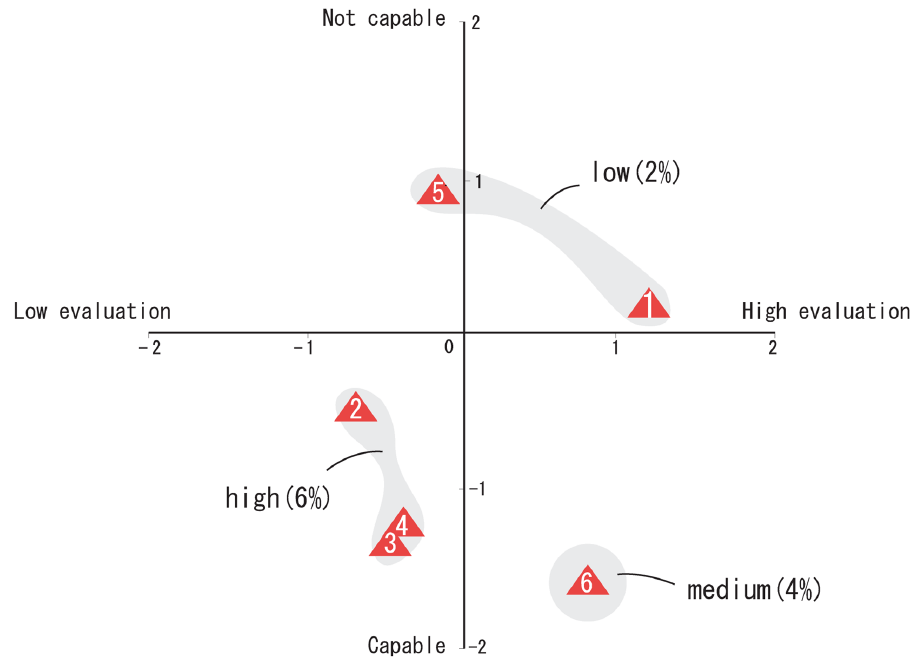
Figure 13. Scatter diagram based on the proportion levels (rooftop advertising signs).